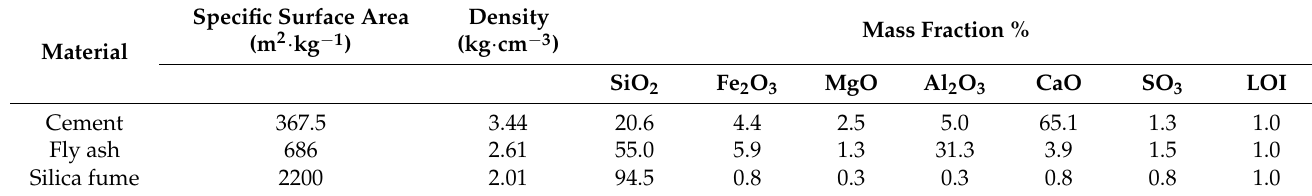
Table 1. Chemical composition and physical properties of the